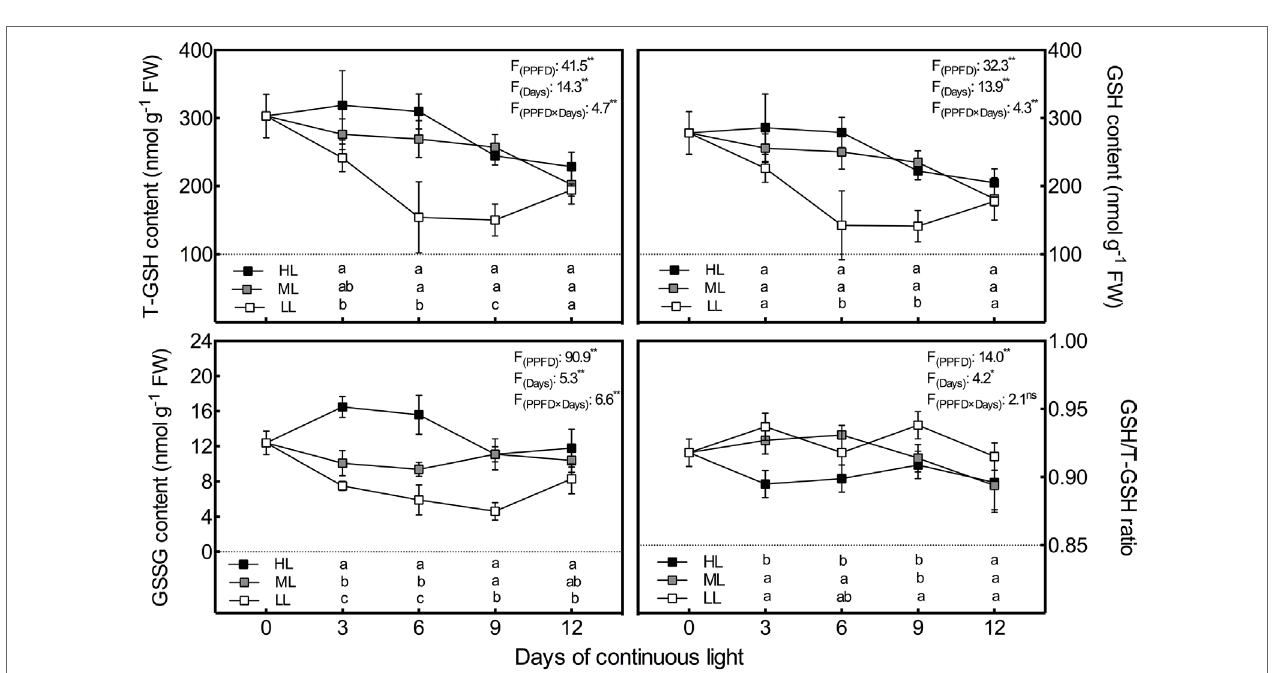
FIgURe 3 | Changes in total glutathione (T-GSH), glutathione (GSH) and oxidized glutathione (GSSG) contents as well as GSH/T-GSH ratio in lettuce leaves grown under continuous light of different intensities: low light (LL, 100 μmol·m −2 ·s −1 ), medium light (ML, 200 μmol·m −2 ·s −1 ), and high light (HL, 300 μmol·m −2 ·s −1 ). Values are means of four replicates ± SD. Different letters indicate significant differences between different light intensity treatments at p 0.05 according to Tukey test. F values and significance of the two-way ANOVA considering the factors light intensity (PPFD), days and their interactions were given in the inset. ns , * and ** indicate nonsignificant and significant at p 0.05 and 0.01